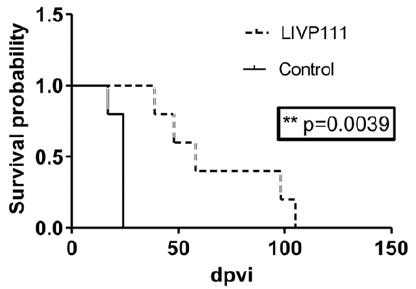
Figure 5. Survival curves of LIVP1.1.1-treated and non-treated STSA-1 tumor-bearing mice. The comparison of the survival between the different treatment groups (n=5) was statistically evaluated by Kaplan-Meier and log-rank (Mantel-Cox) tests (GraphPad Prism, San Diego, CA). P , 0.05 was considered statistically significant. **